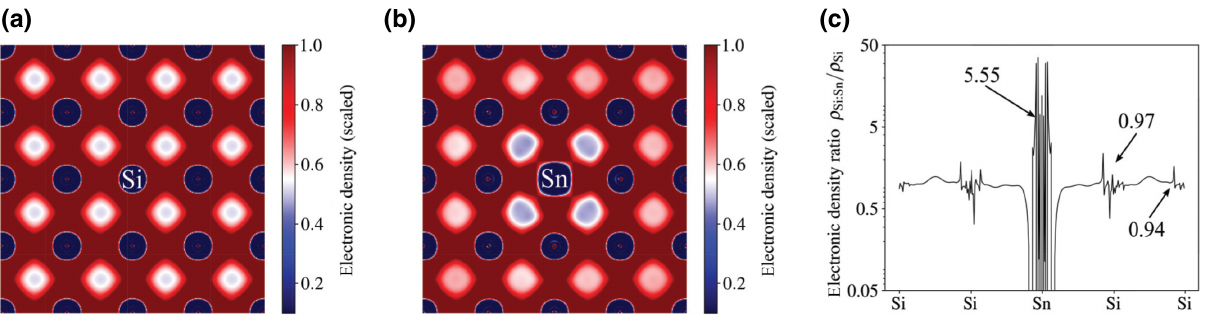
FIG. 1. PBE-DFT electron-spin densities computed along a (cid:5) 100 (cid:6) plane of a 4 × 4 × 4 supercell for (a) the immaculate Si case and (b) the Si:Sn case. In both cases, an electron is introduced and constrained to the conduction-band edge. (c) The ratio of a diagonal cross section of the two densities, where specific values at symmetry-inequivalent nuclear centers are marked for reference. The oscillations are attributable to the failure of the plane-wave basis to satisfy Kato’s cusp